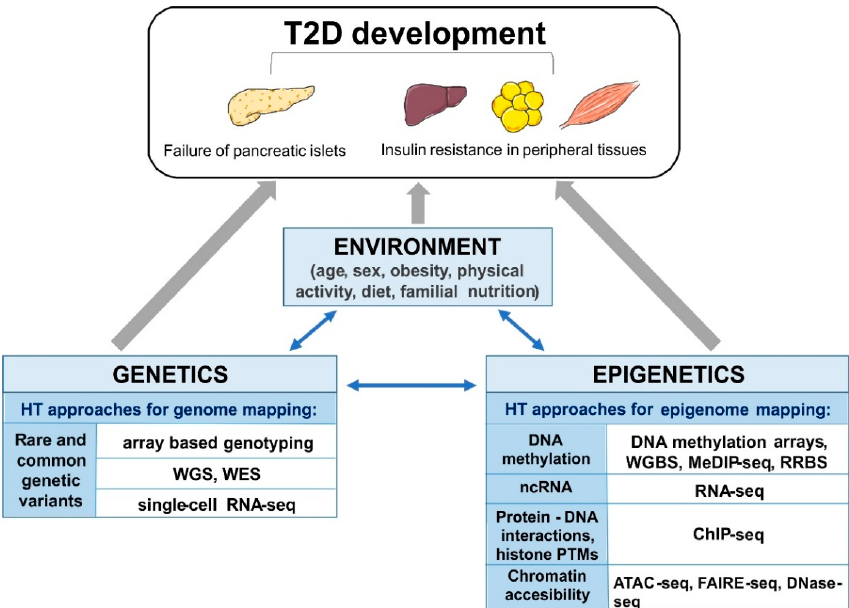
Figure 1. The schematic overview of the interplay of mechanisms involved in development of type 2 diabetes (T2D), and high-throughput (HT), next generation sequencing (NGS) approaches applied to study (epi)genetic modifications. Whole genome-seq (WGS), whole exome-seq (WES), RNA-sequencing (RNA-seq), single-cell RNA sequencing (single-cell RNA-seq), whole genome bisulfite sequencing (WGBS), reduced representation bisulfite sequencing (RRBS), methylated DNA immunoprecipitation sequencing (MeDIP-seq), chromatin immunoprecipitation-sequencing (ChIP- seq), Assay for Transposase-Accessible Chromatin using sequencing (ATAC-seq), Formaldehyde-